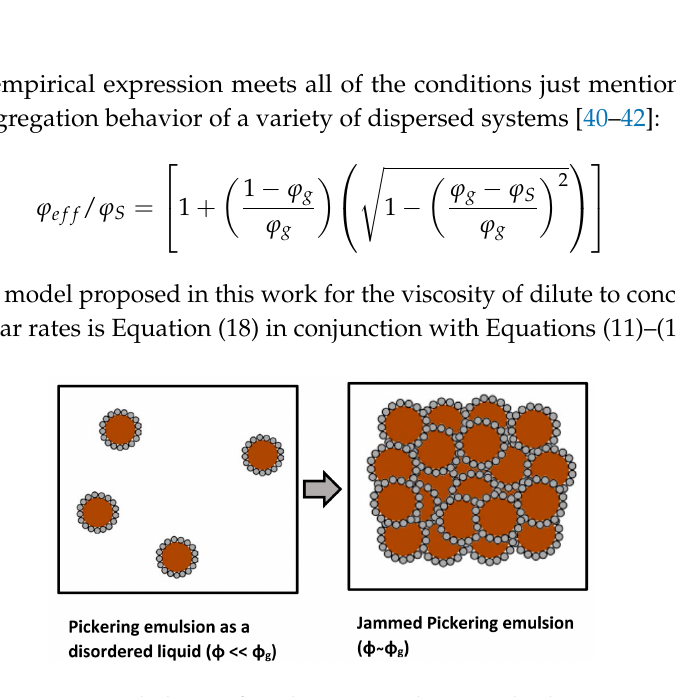
Figure 7. Change in morphology of Pickering emulsion with the increase in composite droplets Figure concentration.